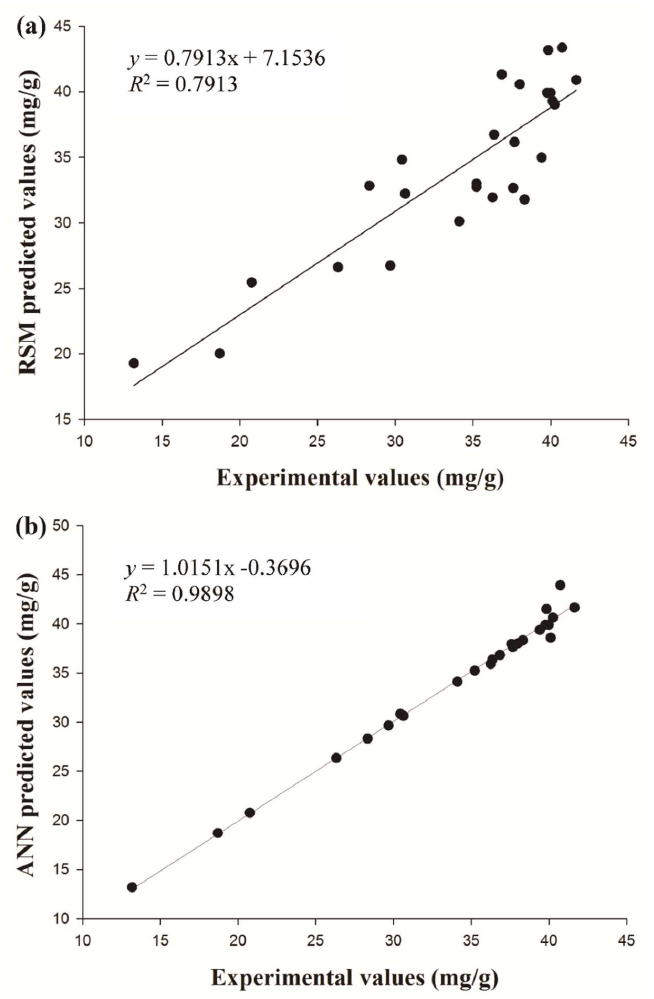
Figure 5. Comparison of experimental data with the predicted value obtained by ( a ) the RSM and ( b ) ANN models.